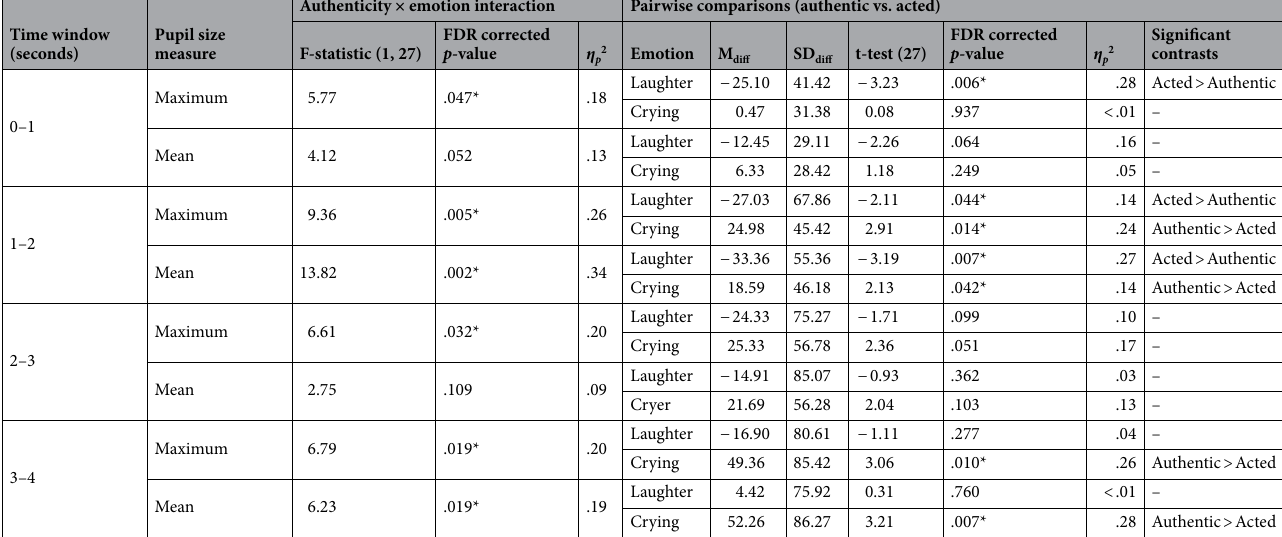
Table 1. F-statistic (numerator and denominator degrees of freedom), p -value after multiple comparison correction with False Discovery Rate (FDR) and partial eta squared ( η p 2 ) for the authenticity by emotion interaction on maximum and mean pupil size, in each time window, are presented. Mean difference (M diff ), standard error difference (SD diff ), t-test (and degree of freedom), p -value after FDR correction and η p 2 are also presented for the follow-up post-hoc pairwise comparisons whereby authentic versus acted vocalizations were contrasted for each emotion (whilst means and SD per condition are provided in the Results’ section text). Statistical significance level: * p <